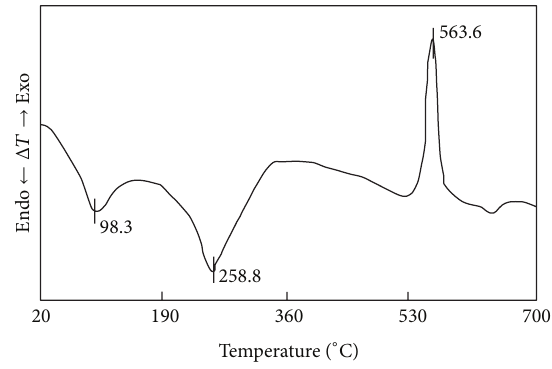
Figure 1: DTA curve of the